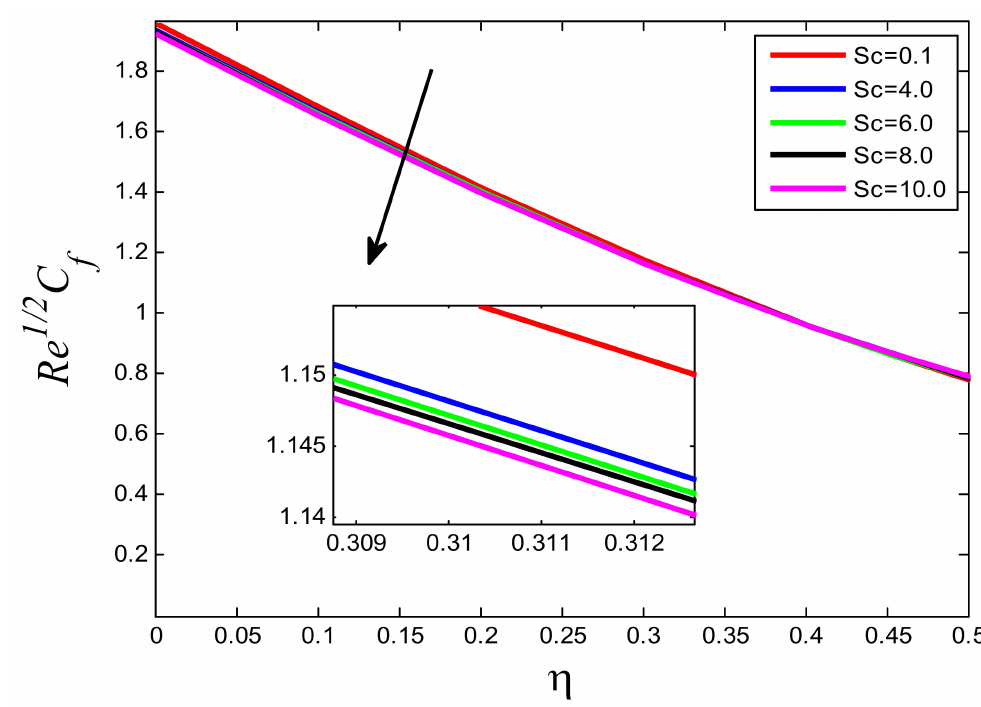
Figure 31. Influence of Sc on Re 1/2 C f